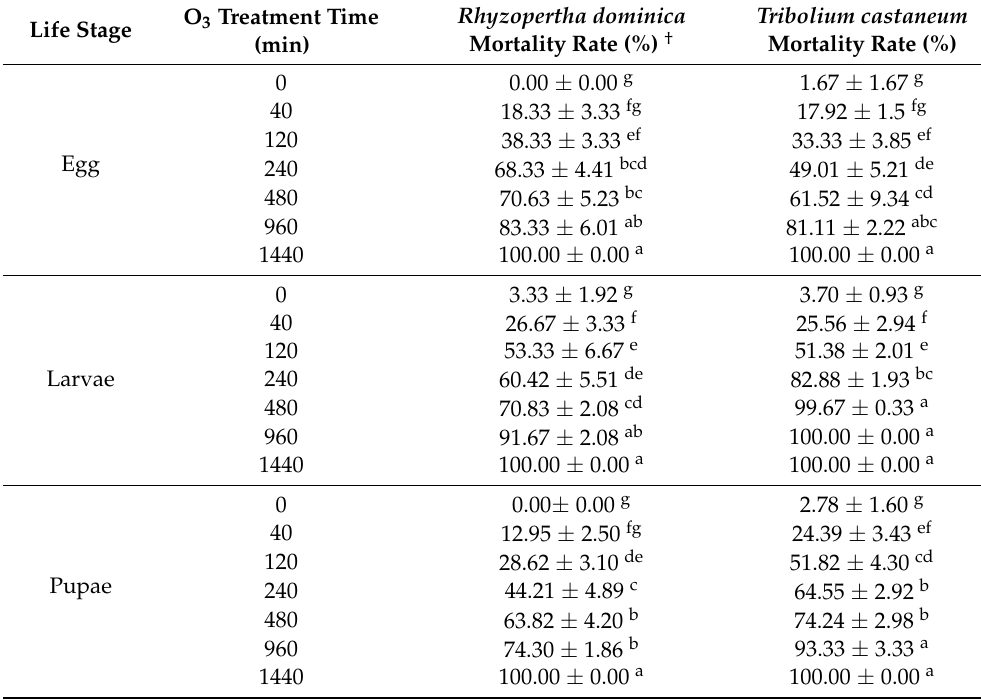
Table 2. Efficacy of O 3 duration at 700 ppm on all life stages of Rhyzopertha dominica and Tribolium castaneum